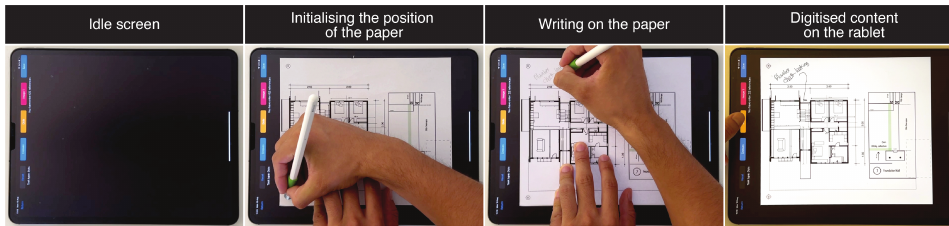
Figure 12. Blueprints annotation